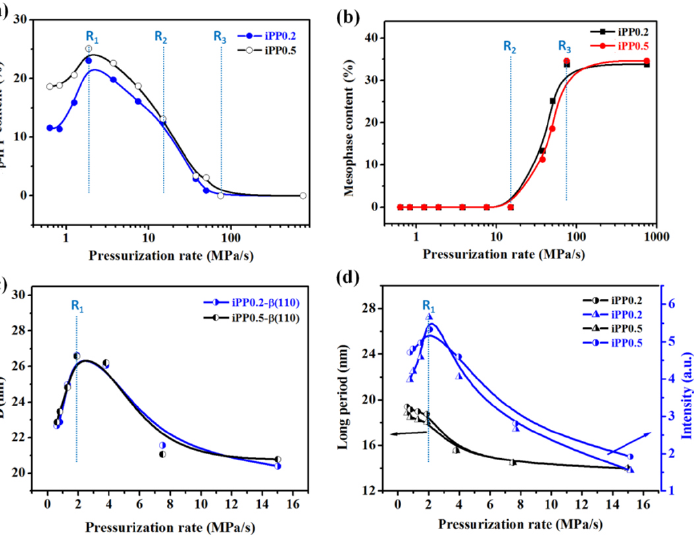
Figure 7. ( a ) Contents of β− and ( b ) mesomorphic phases of iPP0.2 and iPP0.5 as a function of pressurization rate; ( c ) Changes in D and ( d ) L, I max of β crystal in iPP0.2 and iPP0.5 samples with pressurization rates.